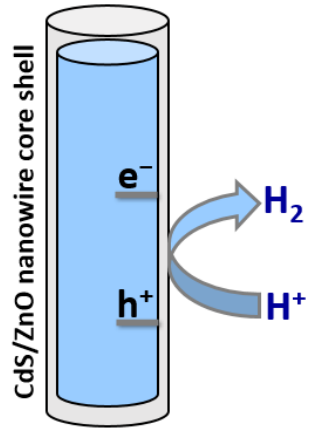
Figure 4. Schematic diagram of photocatalytic H 2 production using CdS/ZnO core – shell nanowire.